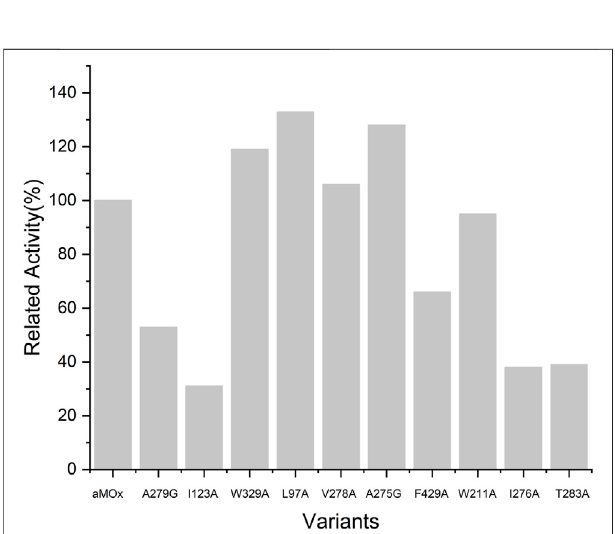
FIGURE 4 | (A) Analysis of the aMOx substrate ’ s binding pocket. Residuals consisting of the aMOx substrate-binding channel are shown in red and those of CYP116B5 are shown in green. (B) Key residuals that affect the AM selectivity of aMOx. Key residuals are marked in yellow.